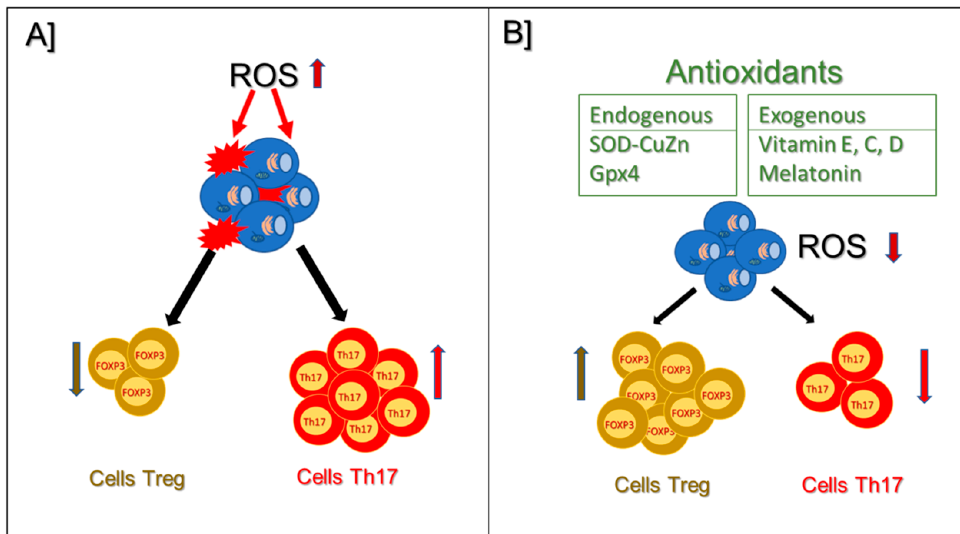
Figure 7. The role of antioxidants in maintaining the inflammatory balance between Treg cells and TH17 cells. ( A ) The figure shows that in a state of oxidative stress there is an imbalance between Treg cells (green arrow) and TH17 cells (red arrow). ( B ) In the presence of antioxidants (endogenous and exogenous), the number of Treg cells increases (green arrow), maintaining a compensatory balance to modulate inflammation.